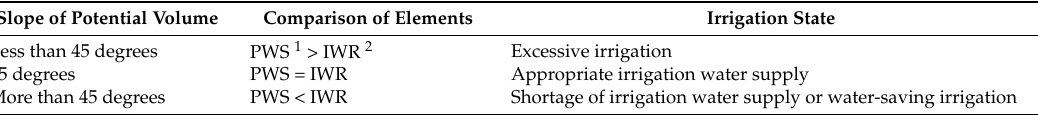
Table 4. Classification of irrigation vulnerable